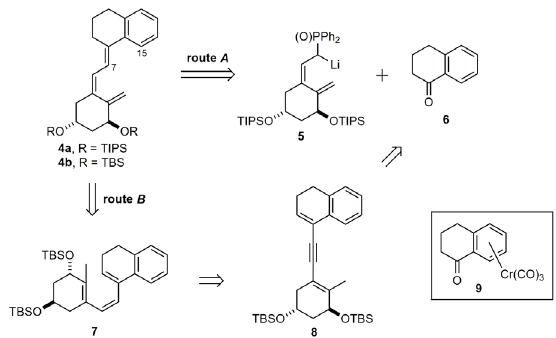
Figure 2 - Retrosynthesis of target 4 by the Wittig-Horner and Dienyne approaches.